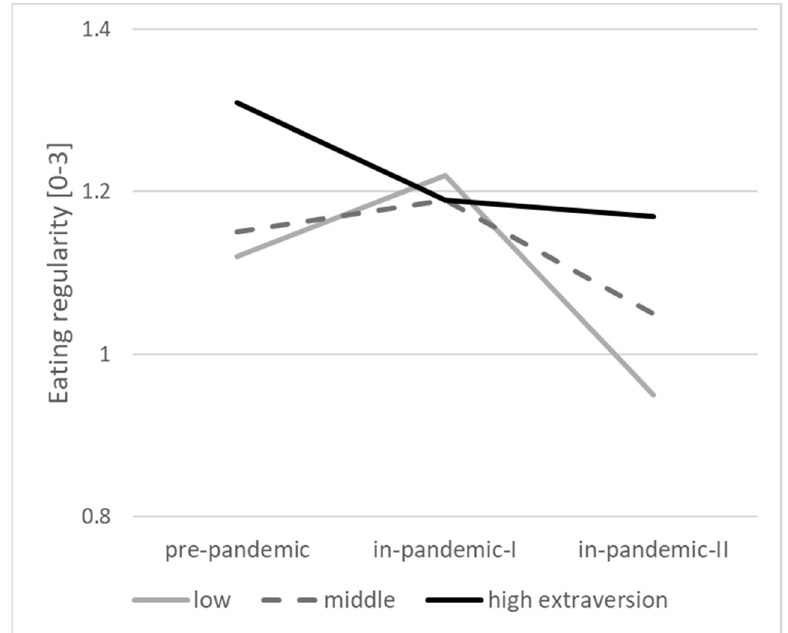
The moderator role of personality on changes is shown in Table 3 in Model 2. Scoring higher in extraversion and lower in neuroticism were associated with lower levels of depressive symptoms and a higher level of leisure-time physical activity. Higher scores in neuroticism were associated with lower eating regularity. There was a statistically significant interaction between extraversion and time for eating regularity, i.e., people scoring low in extraversion were more likely to decrease their eating regularity during the pandemic (see Figure 3).